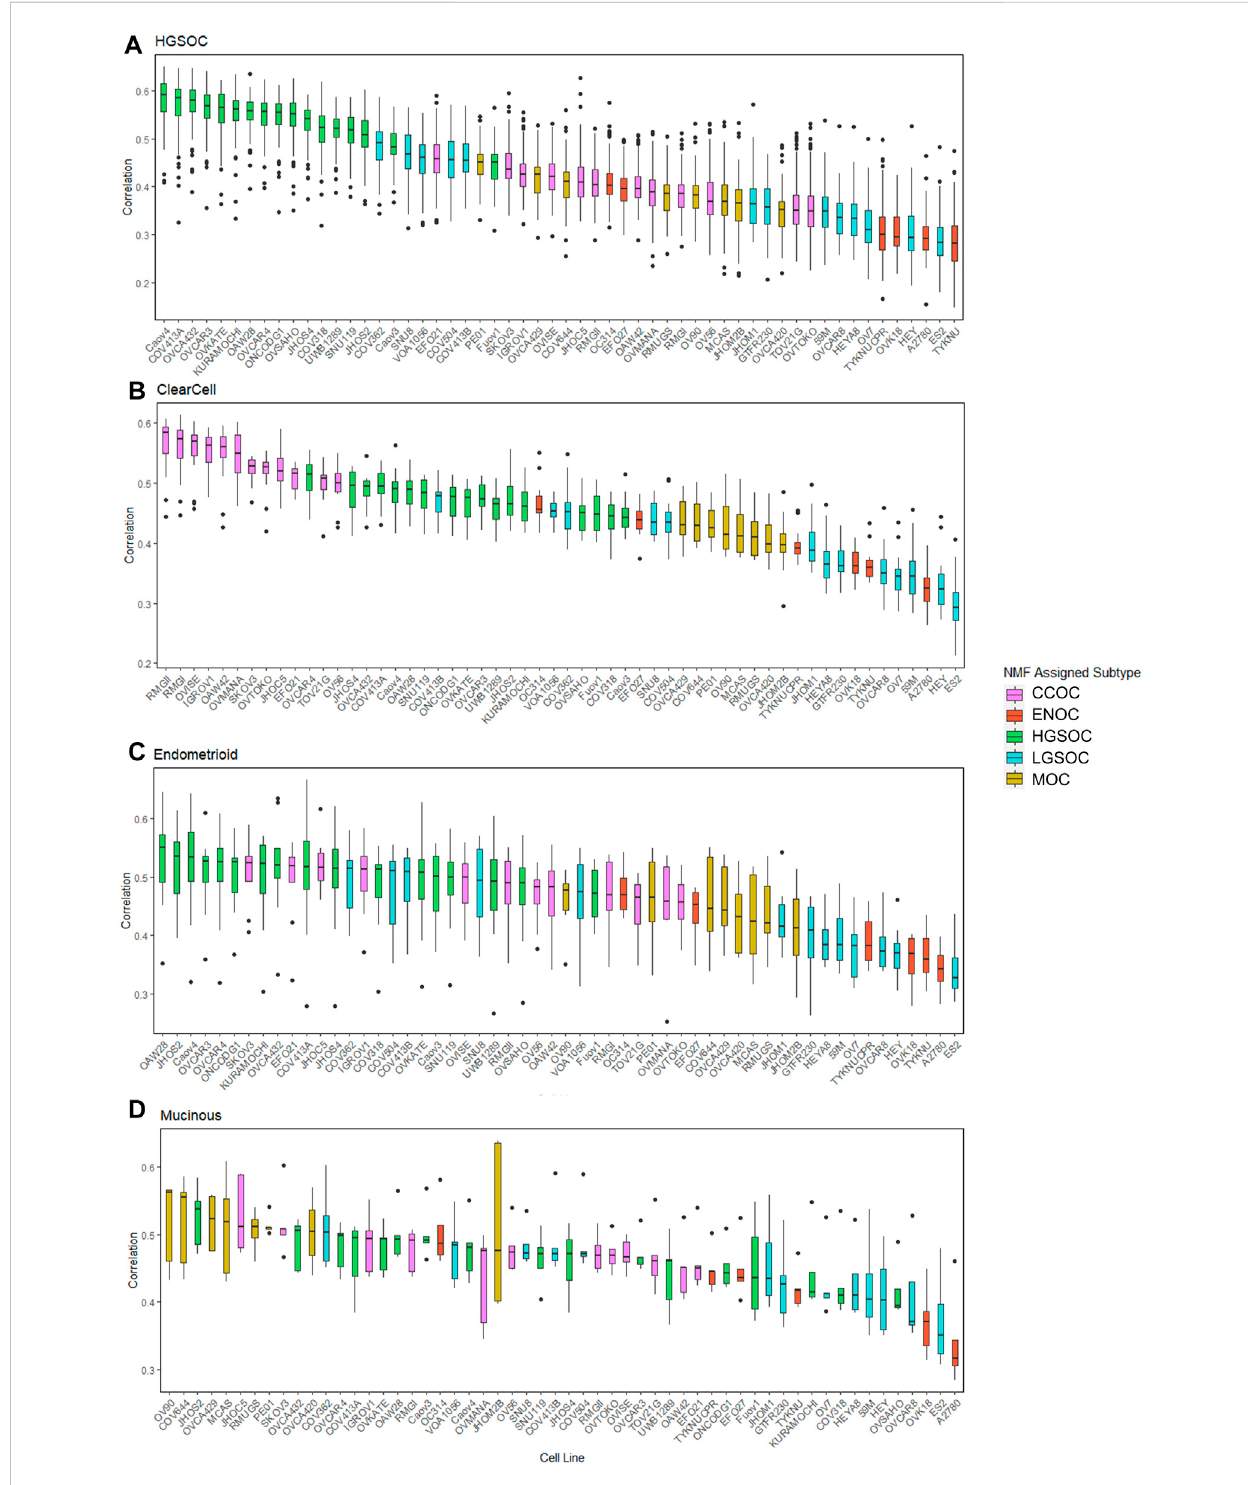
FIGURE 5 Distribution of correlations between cell lines and primary tumors of varying subtypes. Each boxplot is ordered in decreasing rank of median correlation between a particular cell line and all tumors of each subtype, (A) HGSOC tumors, (B) CCOC tumors, (C) ENOC tumors and (D) MOC tumors. Each box is colored based on subtype assigned to each cell line by